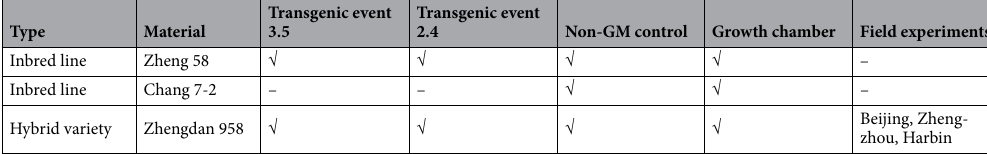
Table 1. Transgenic and non-transgenic maize lines used in this